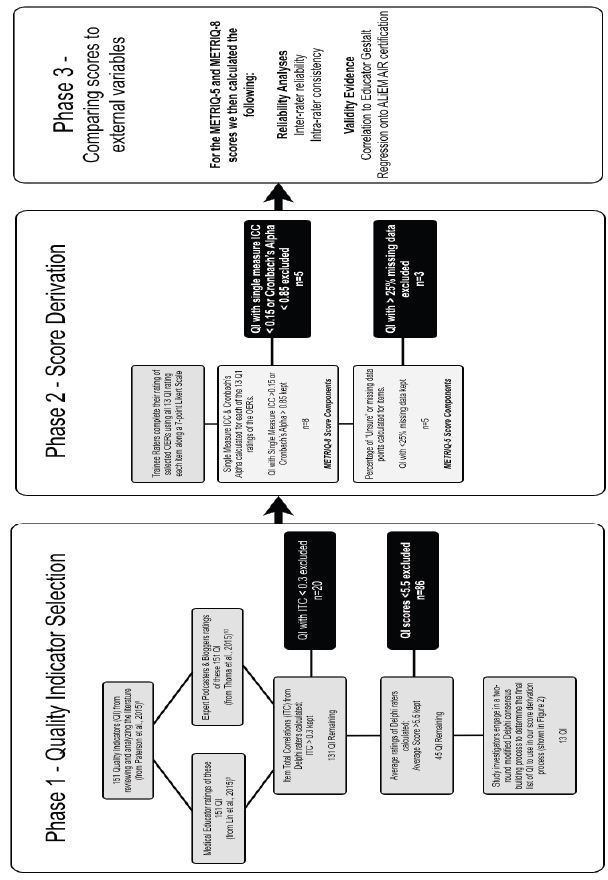
Flow diagram of study design. Phase 1 depicts the quality-indicator (QI) selection process, Phase 2 depicts the score derivation process based on the reduced list of QIs, and Phase 3 describes the reliability and validity testing data for the two derived instruments for scoring the quality of medical blogs and podcasts.QI, quality indicator; ITC, item total correlation; ICC, intraclass correlation coefficient; ALiEM, Academic Life in Emergency Medicine; AIR, approved instructional resources.